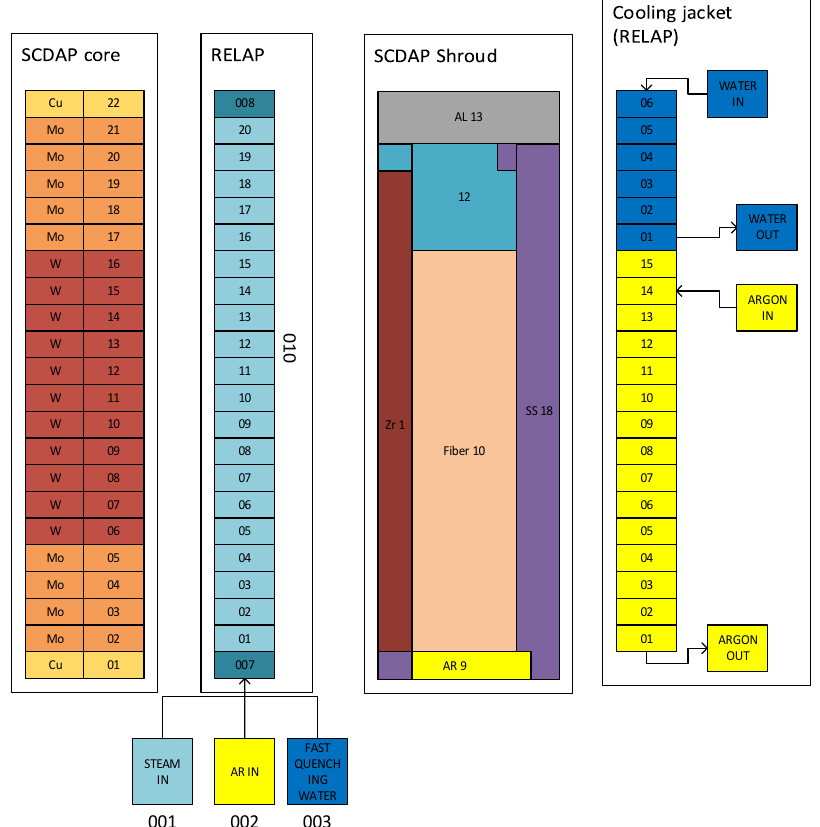
Fig. 3. QUENCH-14 test bundle nodalisation for RELAP5/SCDAP